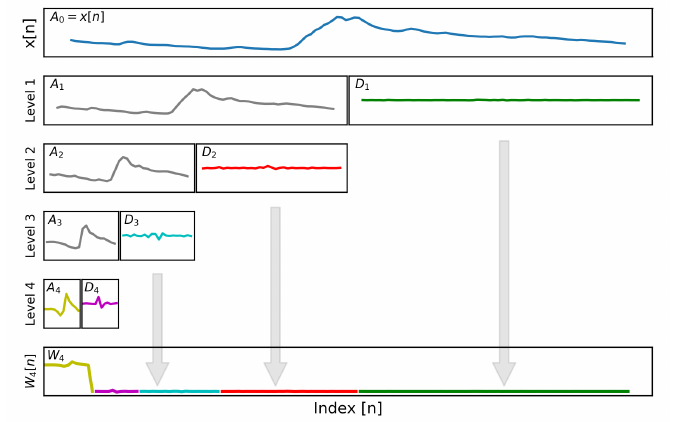
Figure 2. The physiological signal, x [ n ] , has a sparse representation in the wavelet domain, W 4 [ n ] , through the application of a multilevel discrete wavelet transformation. This technique was applied within the microcontroller to allow for effective signal compression. Each level of the transformation represents low-passed and band-passed versions of the original signal at different